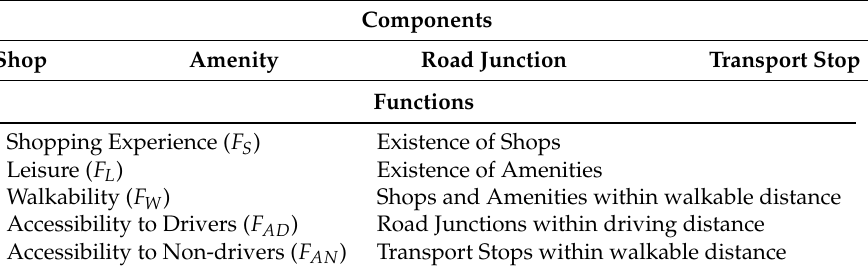
Table 3. Components and functions of a shopping